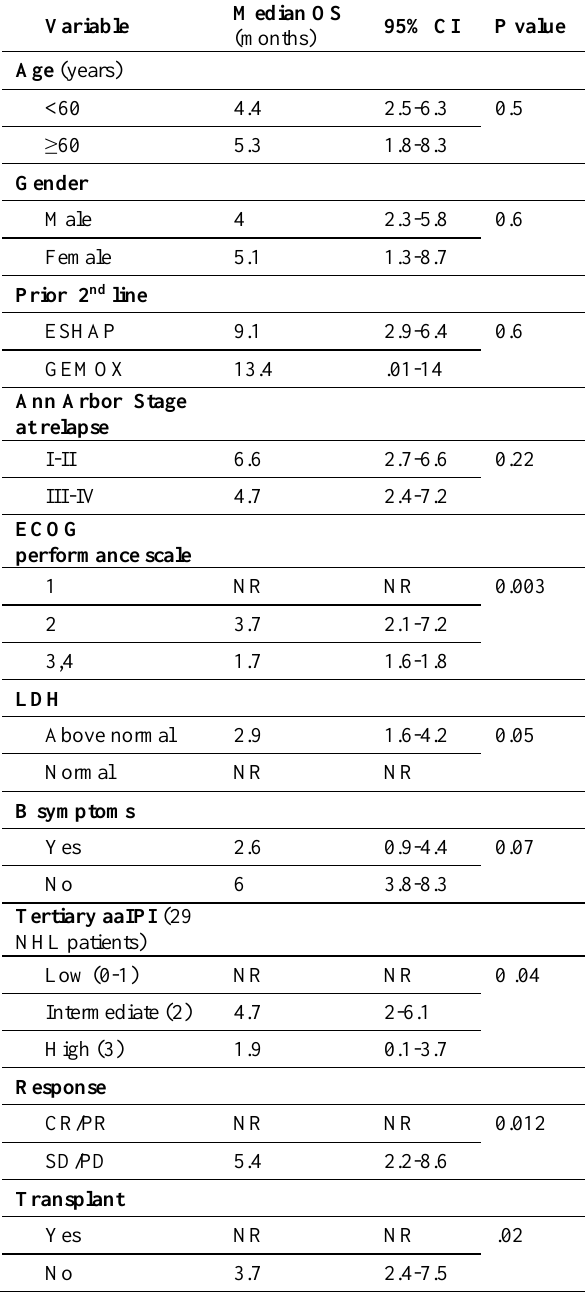
Table 2. Univariate analysis for factors affecting